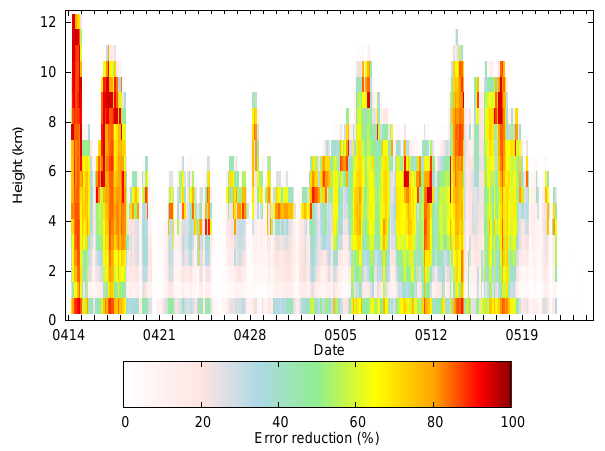
Fig. 3. Relative reduction of the assumed a priori uncertainty of the ash emissions by the inversion